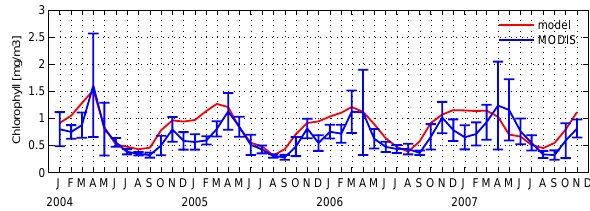
Figure 2. Monthly domain-averaged surface chlorophyll from the shelfbreak model 776 Fig. 2. Monthly domain-averaged surface chlorophyll from the (red) and Aqua-MODIS data (blue, with one standard deviation). The model data are 777 taken from the top vertical layer of the model. 778 shelfbreak model (red) and Aqua-MODIS data (blue, with one stan- dard deviation). The model data are taken from the top vertical layer of the